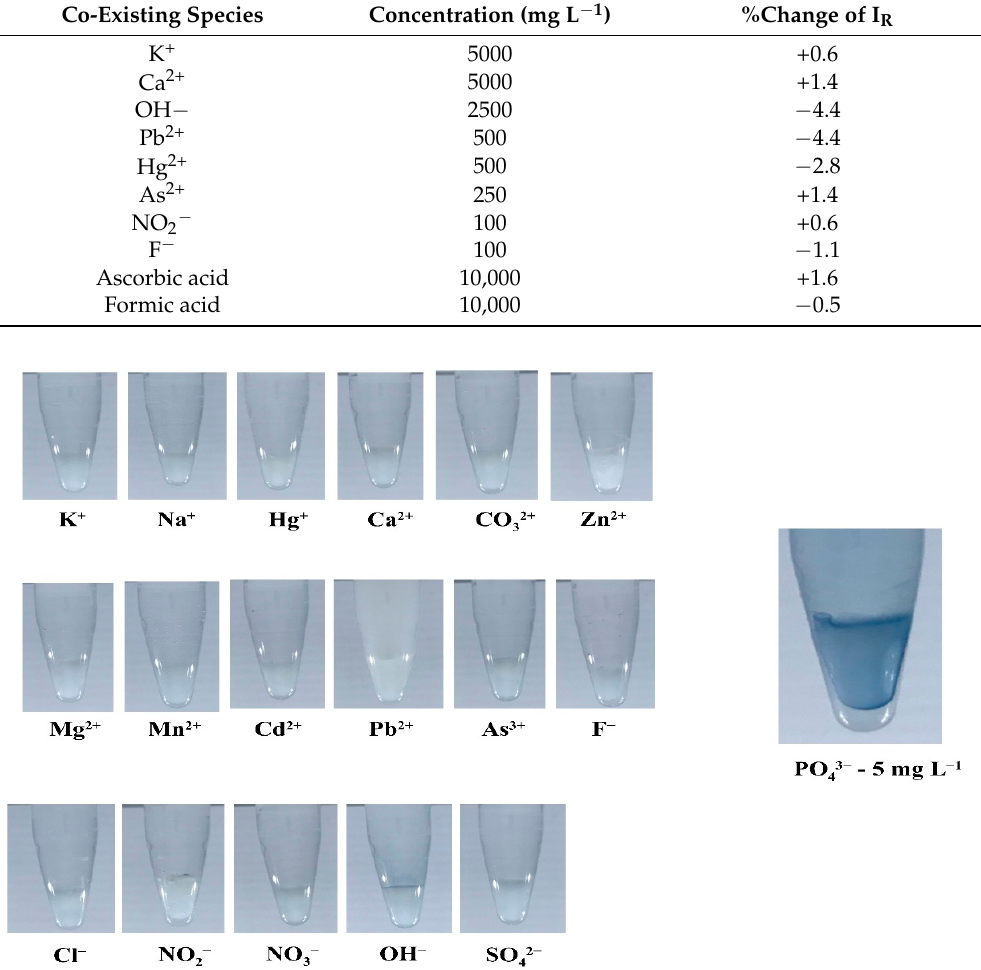
Figure 6. Colorimetric products obtained from the testing of various interference ions with the hydrogel test kit for phosphate.